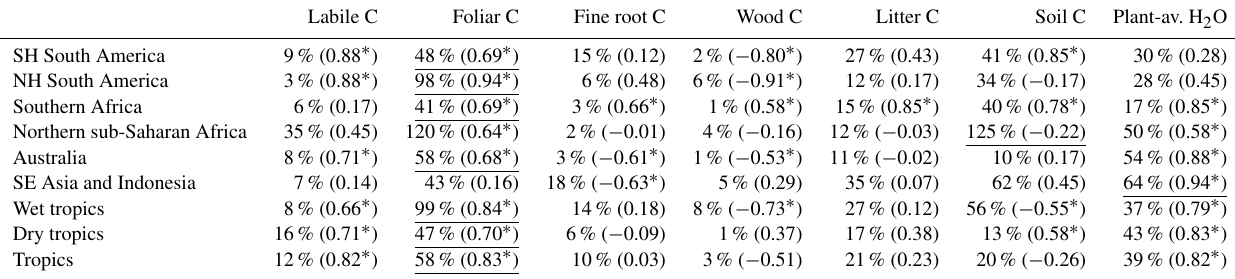
Table 5. IAV of 2001–2015 regional and pan-tropical NBE lagged effects attributable to annual anomalies in column-denoted ecosystem states (Eq. 22) as % of total NBE lagged effects ( (cid:49) NBE LAG ) IAV; bracketed values correspond to Pearson’s correlation coefficients between single-state NBE lagged effects and total (cid:49) NBE LAG ; “ ∗ ” denotes p values<0.05. The underlined values denote the maximum contribution in each